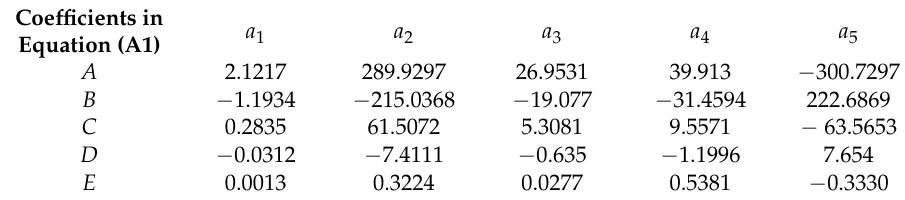
Table A1. Coefficients in Equation (A2).